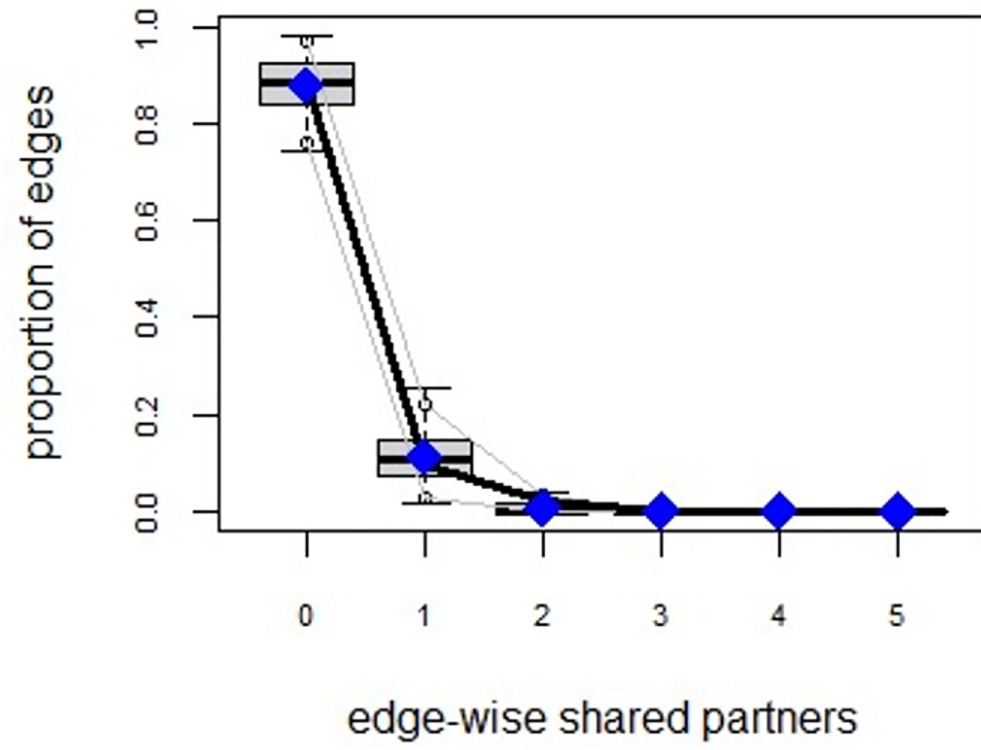
Fig 15. Multiplexity in the beta community—goodness of fit [24] edge-wise shared partners.